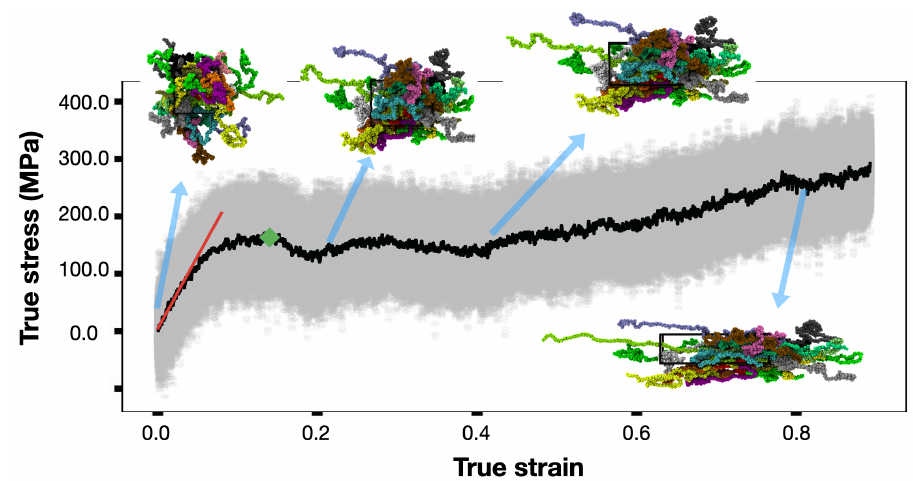
Figure 1. Stress–strain profile obtained from the deformation simulations along with the representa- tive snapshots of an amorphous polymer box illustrating the deformation process at different strain values. The polymer box consists of 10 P3HB chains, each with 500 monomer units. Deformation simulations were performed at 300 K by applying a constant strain rate of 1 × 10 9 s − 1 . The grey dots represent the instantaneous values and the black line represents the moving average obtained over a window of 1000 points. The red line represents the linear fit in the small-strain regime used to determine Young’s modulus. Yield stress is identified by the green diamond. Representative snap shots of the simulated polymer structure at four different strains are shown, where each chain in the structure is colored separately for